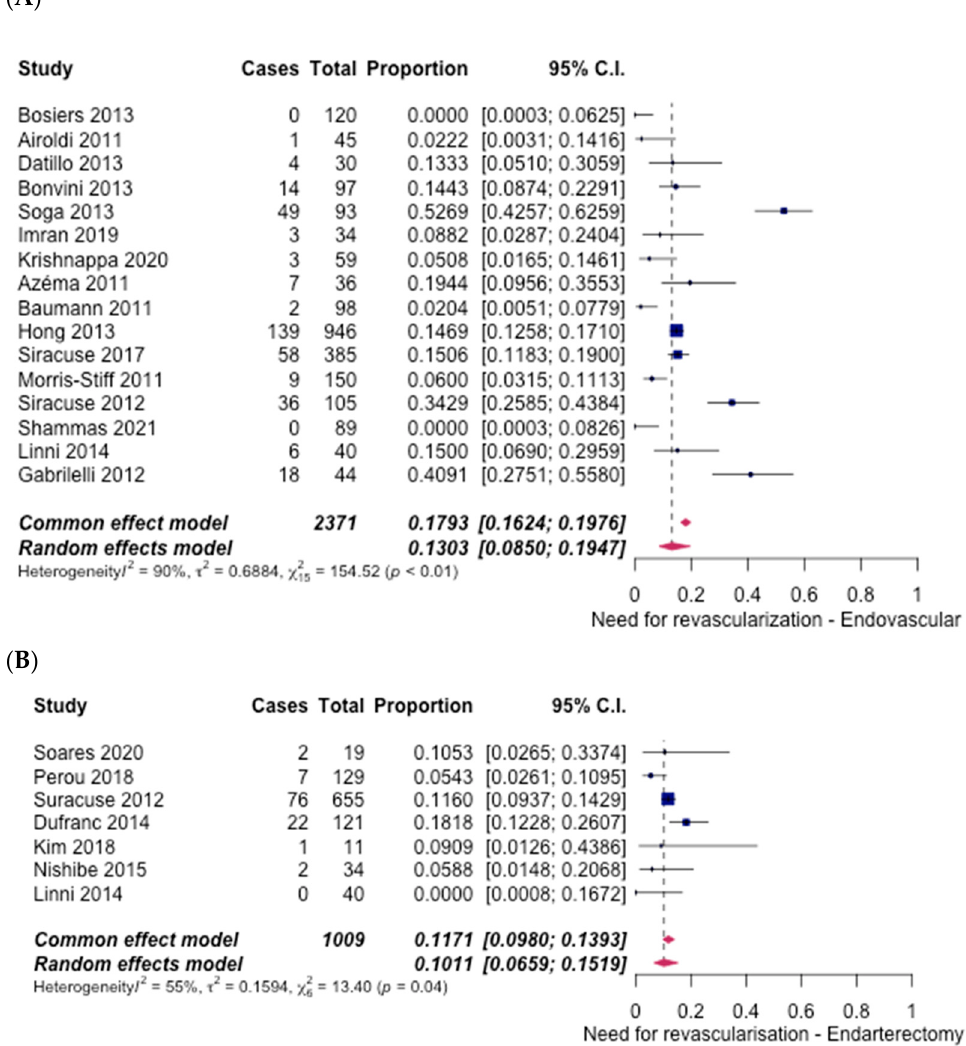
Figure 5. Forest plot for need for revascularisation. ( A ) Endovascular intervention [6–12,14–20,22,27]. ( B ) Endarterectomy [5,6,22–26].